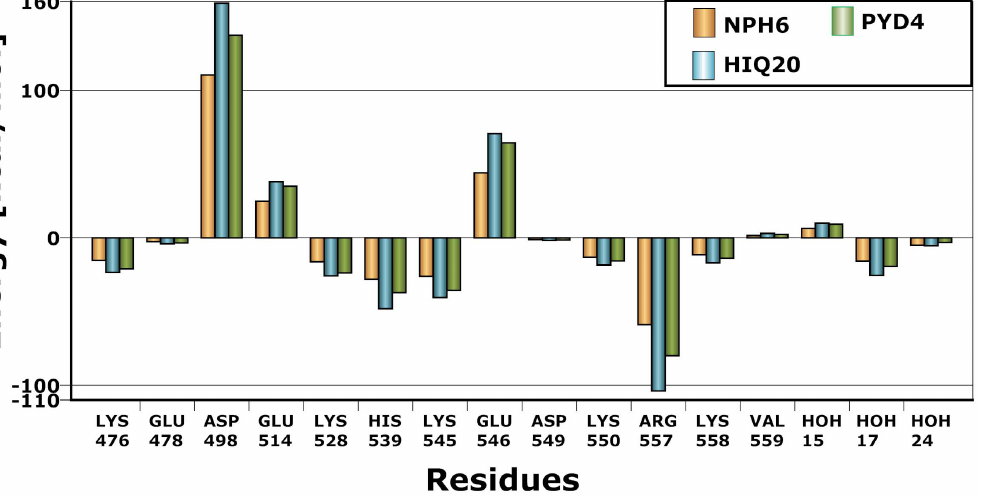
Figure 3. Residues contribution to Binding affinity. Residue energy contribution to the overall binding affinity from the FMO calculation (only significant numbers are shown) is shown for representative compounds. All values are provided in kcal/mol.